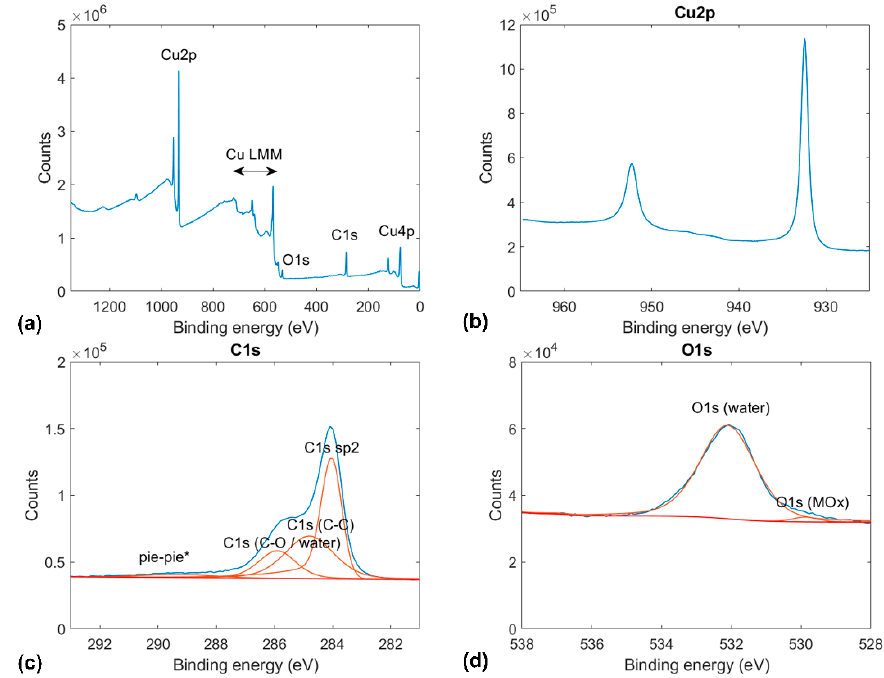
Figure 2. Indexed XPS results for graphene on copper: ( a ) full x-ray photoelectron spectrograms and spectrograms for the ( b ) Cu2p, ( c ) C1s, and ( d ) O1s orbitals.